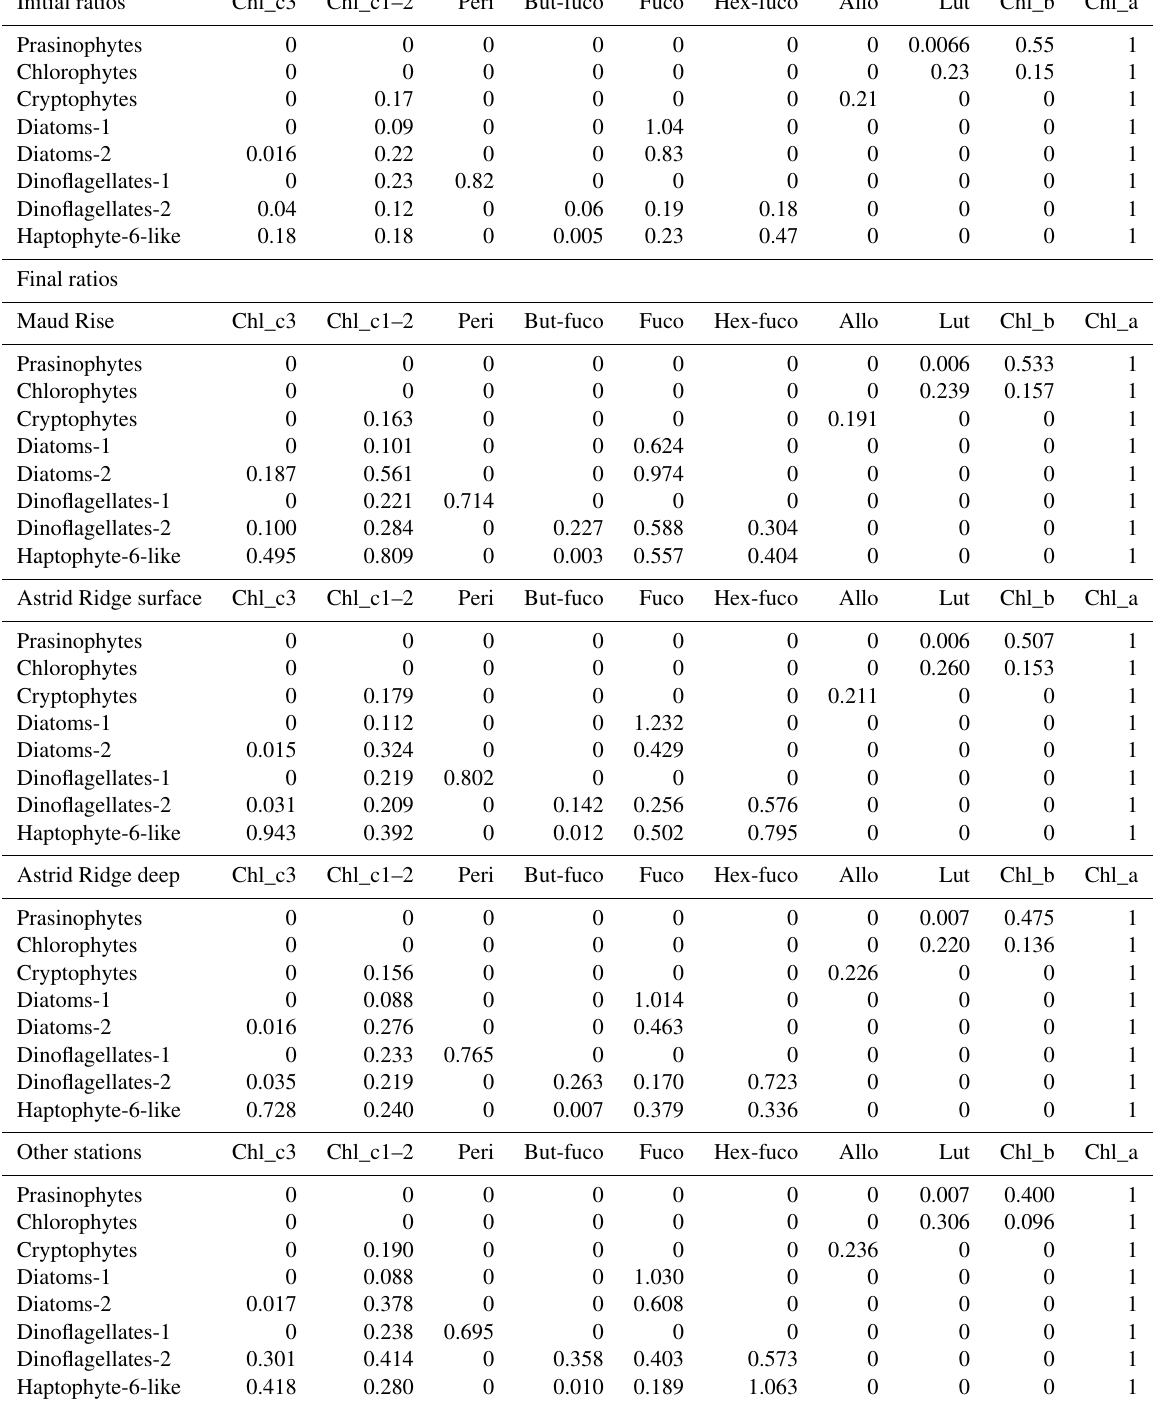
Table B2. Initial pigment-to-Chl a ratios used in the CHEMTAX analysis and the final ratio matrices for each cluster (average of the six best-performing runs of the second step; see